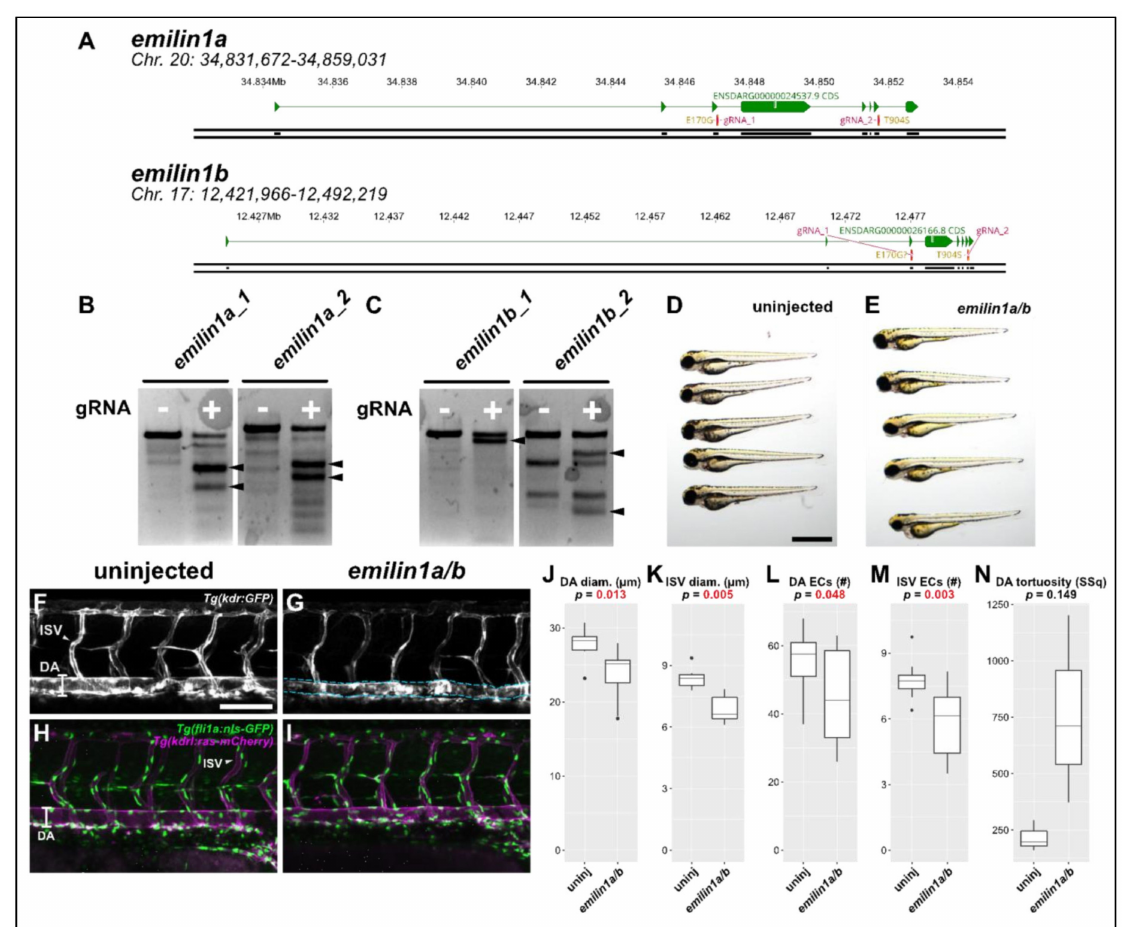
Figure 5. Knocking out emilin1a/b reduces DA and ISV diameter, endothelial cell counts. ( A ) Genomic region of chromosomes 20 and 17 containing emilin1a and b , respectively. Patient mutations E170G and T904S are indicated and their corresponding gRNAs are overlaid (magenta). ( B ) T7 endonuclease activity against gRNA target amplicons for emilin1a . Supernumerary bands are generated for both injected gRNAs (filled arrowheads). ( C ) Similar T7 assay as ( B ), but applied to emilin1b target amplicons. ( D ) Brightfield macroscopic image of a representative series of uninjected 3 dpf larvae. Scale bar: 1 mm. ( E ) Similar image of emilin1a/b fish. Note that fish are generally normal in appearance. ( F ) Confocal micrograph of uninjected 3 dpf Tg(kdr:gfp) trunk vasculature. DA: dorsal aorta, ISV: intersegmental vessel, scale bar: 100 µ m. ( G ) Similar micrograph taken of an emilin1a/b knockout fish. DA is traced in blue to emphasize tortuosity. Note the generally lower diameter of vessels, ( H ) Uninjected 3 dpf Tg(fli1a:nls-gfp); Tg(kdrl:ras-mcherry) trunk vasculature. DA: dorsal aorta, ISV: intersegmental vessel. Endothelial cell nuclei are labelled with GFP, making quantification possible.